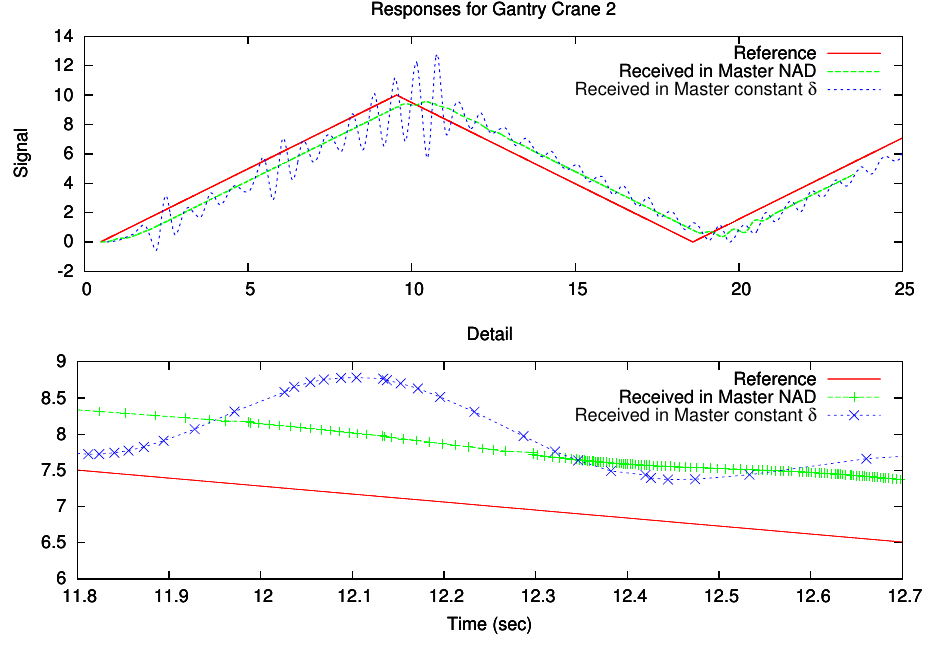
Figure 14. Compared results between NAD and constant deadband in the real Internet link for the gantry crane and the LQR